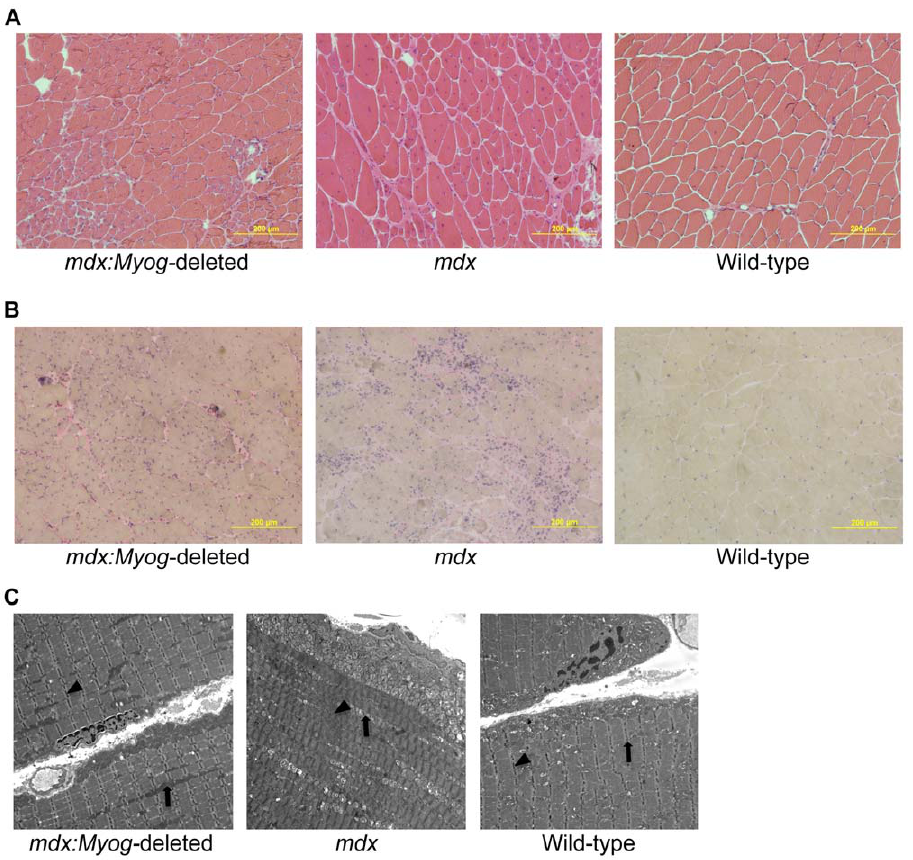
Figure 4. Histologic evaluation of mdx , mdx:Myog -deleted, and wild-type hindlimb muscle. (A) Hematoxylin and eosin-stained mdx and mdx:Myog -deleted muscle sections both displayed classic characteristics of regeneration, which include wide variations in myofiber diameter and centrally located nuclei, that were not observed in wild-type samples. (B) Van Gieson staining for collagen and elastin revealed similar levels of fibrosis in mdx and mdx:Myog -deleted muscle sections that were not observed in wild-type samples. (C) Ultrastructural analysis with TEM showed that mdx:Myog -deleted muscle sections have reduced mitochondrial swelling when compared to mdx samples. Arrows point out mitochondria. Arrow heads point out sarcomeric Z-lines; note the abnormal Z-lines in mdx muscle.